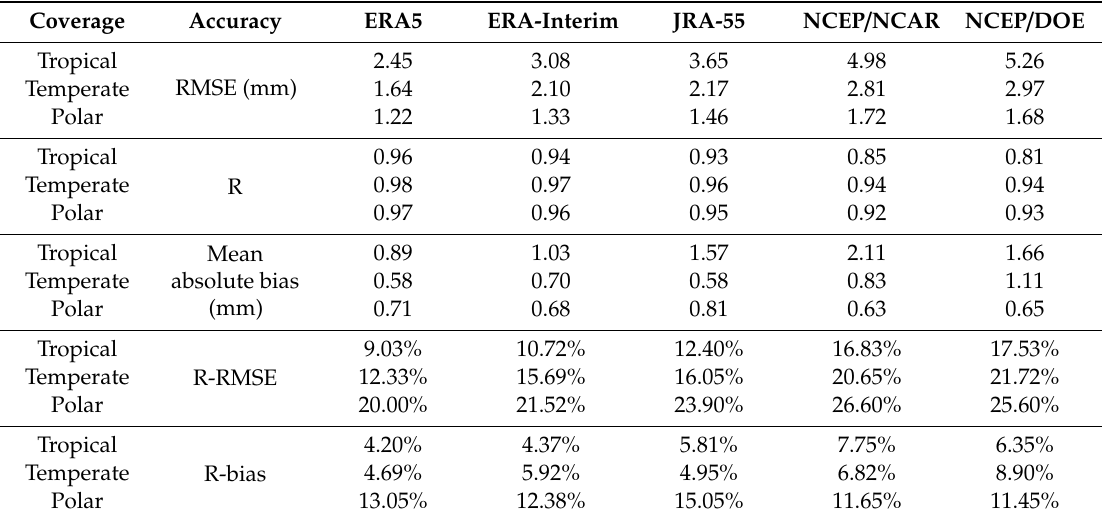
Table 3. R, mean absolute bias, RMSE, R-bias and R-RMSE for ERA5, ERA-Interim,